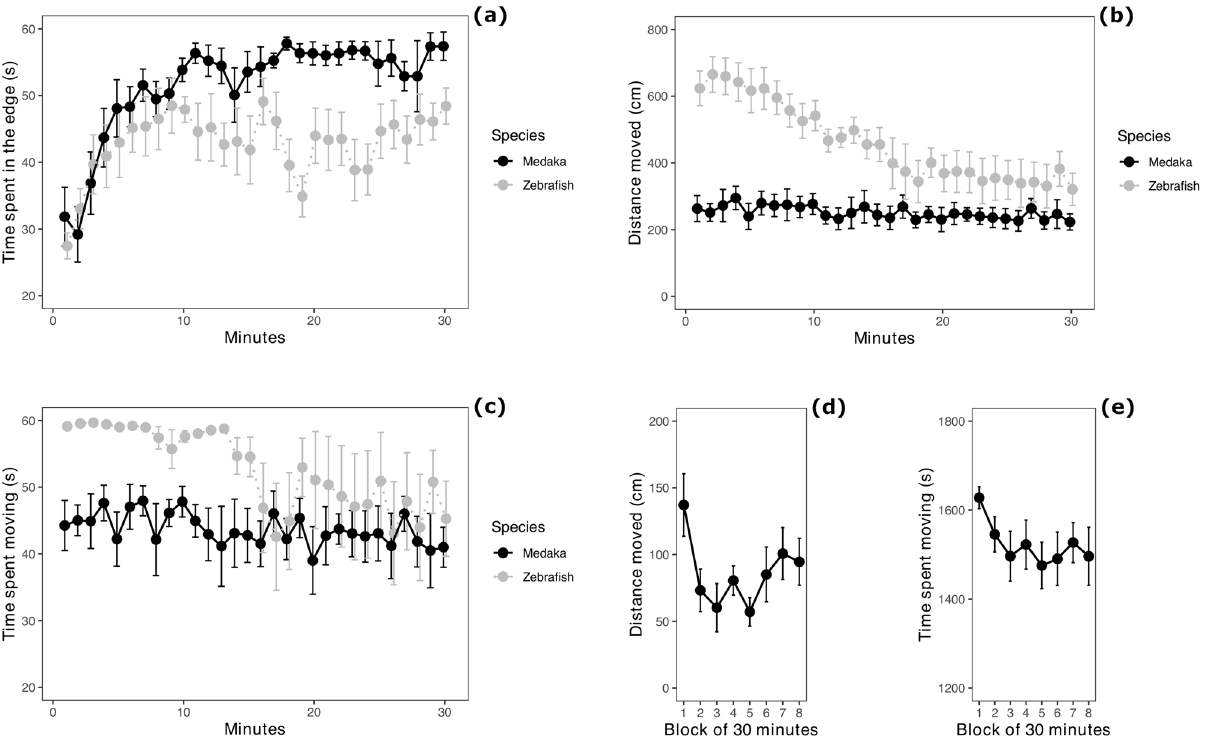
spent moving, divided in 1-min bins; ( d ) activity measured as distance moved in the medaka tested with the extended testing time (4 h), divided in 30-min bins to allow comparison between standard testing time (30 min) and extended testing time; ( e ) activity measured as time spent moving in the medaka tested with the extended testing time (4 h), divided in 30-min bins to allow comparison between standard testing time (30 min) and extended testing time. Data points and error bars represent means and standard errors,